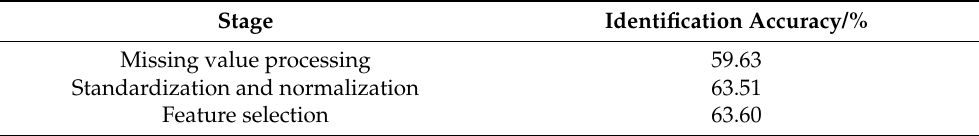
Table 9. Identification effects in different processing